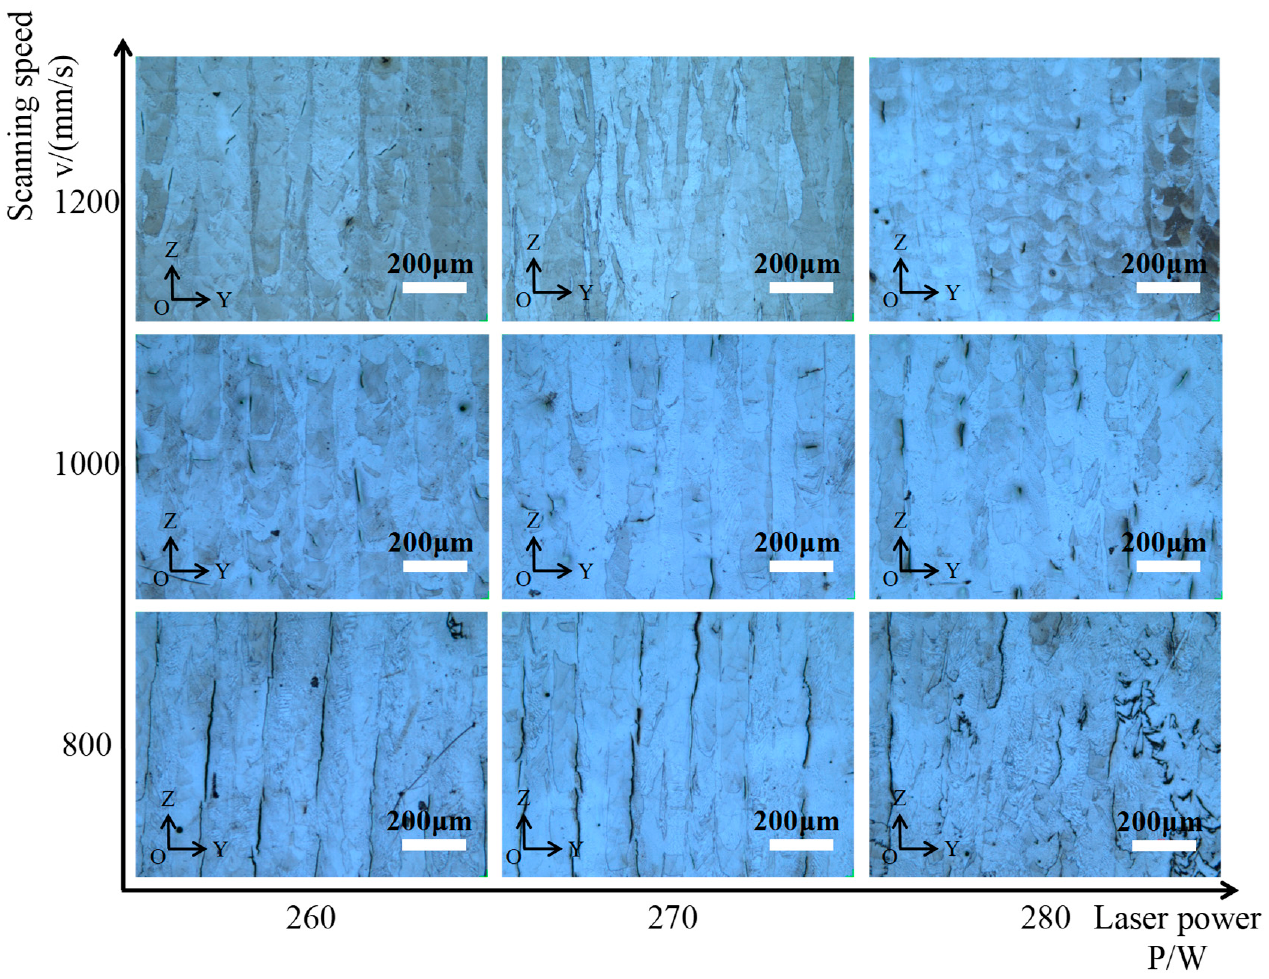
Figure 2. Sample YOZ cross-section under different process parameters.